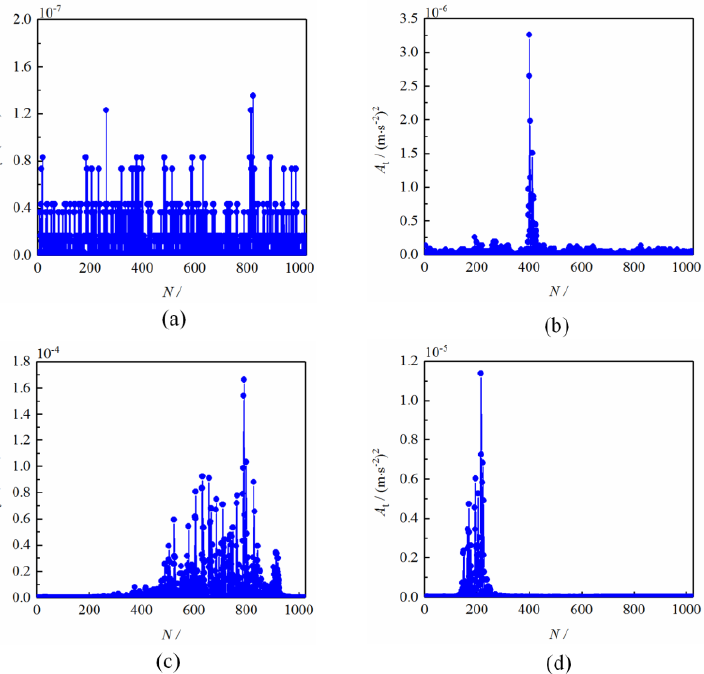
Figure 11. Variance analysis diagrams of different drain states. ( a ) Single water phase, ( b ) Oil–water two-phase, ( c ) Gas–oil–water mixing phase, ( d ) Single gas phase.